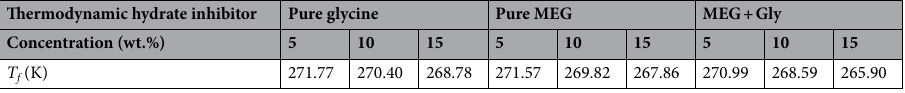
Table 3. The freezing point temperatures (K) of aqueous THI solutions in different